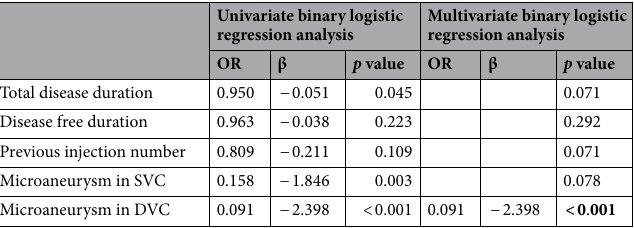
Table 2. Binary logistic regression analysis of factors associated with the presence of suspended scattering particles in motion. OR odds ratio, SVC superficial vascular complex, DVC deep vascular complex.